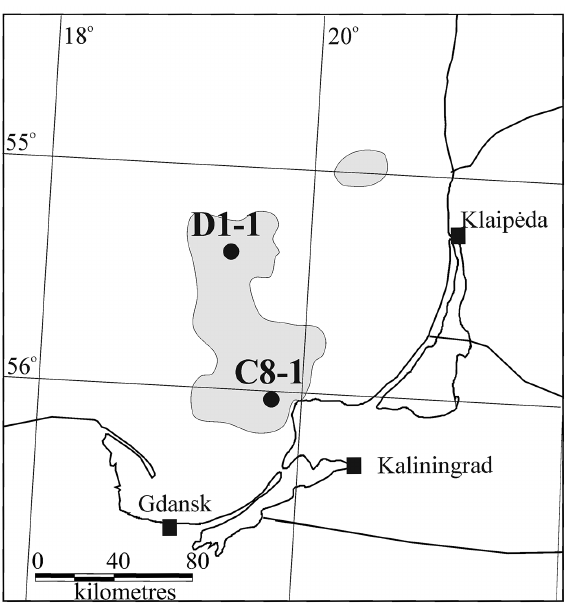
Fig. 1. Distribution of dolerite sills defined by seismic (shaded areas) and drilling (black dots) data.